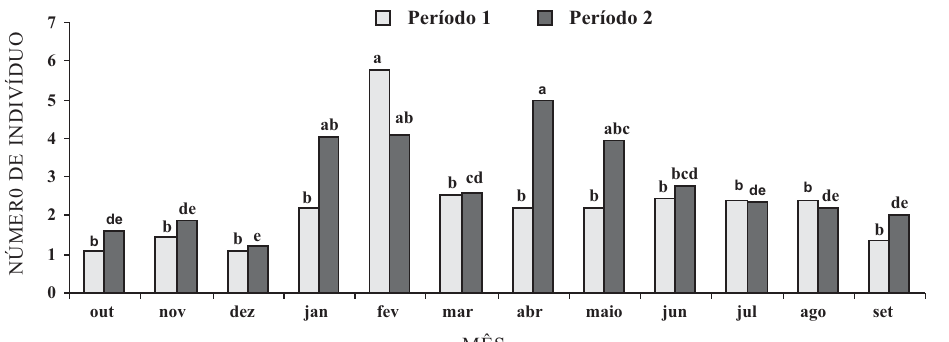
Figura 4. Variação mensal da mesofauna coletada na RPPN da Fazenda Tamanduá no período de outubro de 2003 a setembro de 2004 (período 1) e de outubro de 2004 a setembro de 2005 (período 2). (Valores médios transformados. Letras iguais nas barras de mesma cor não diferem pelo teste de Tukey com p <